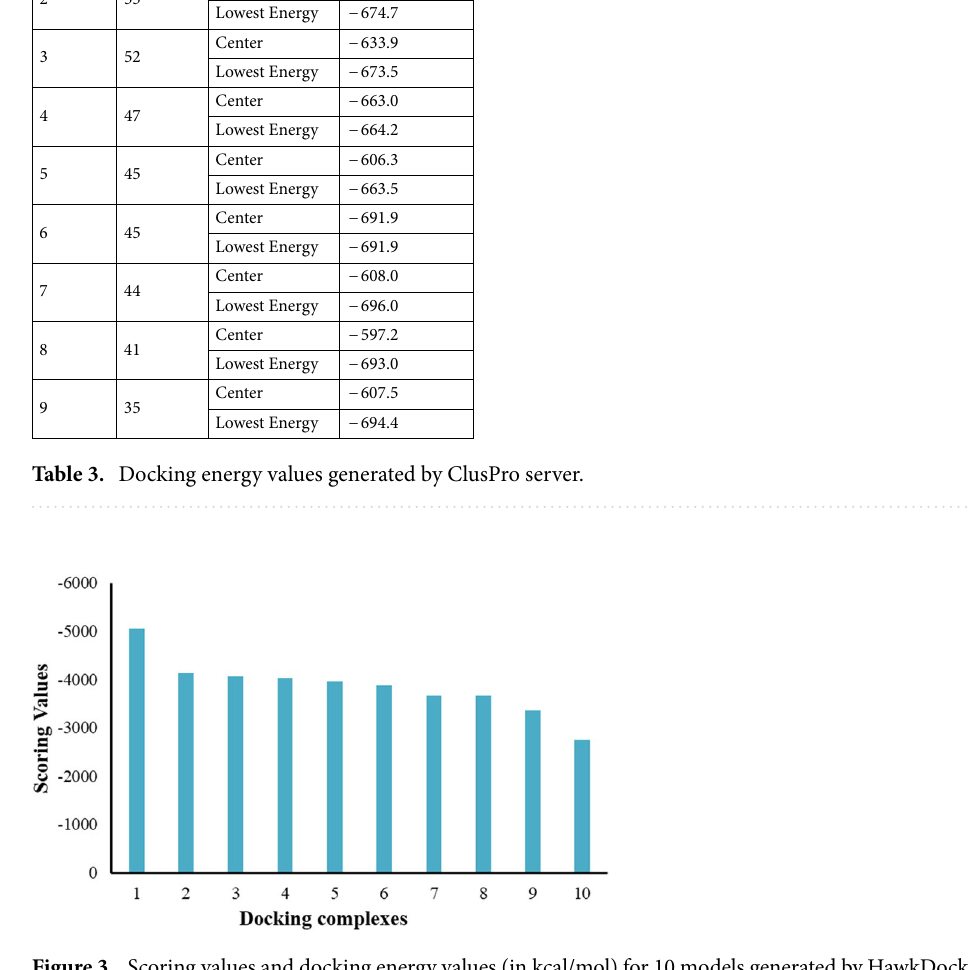
Figure 3. Scoring values and docking energy values (in kcal/mol) for 10 models generated by